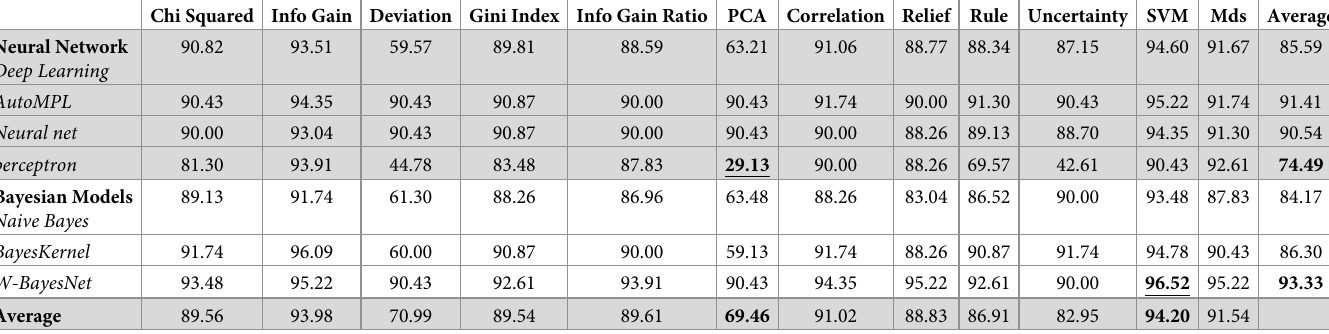
Table 4. The accuracy of neural network and Bayesian models on twelve datasets computed by 10-foldcross validation.